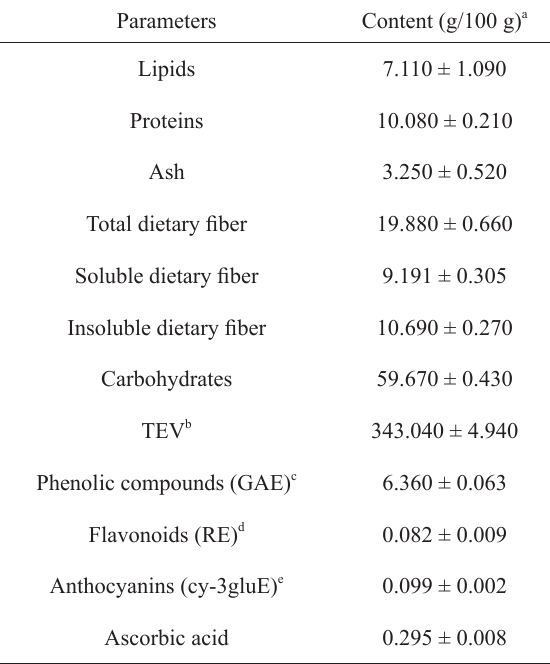
Chemical and phytochemical composition of lychee peel